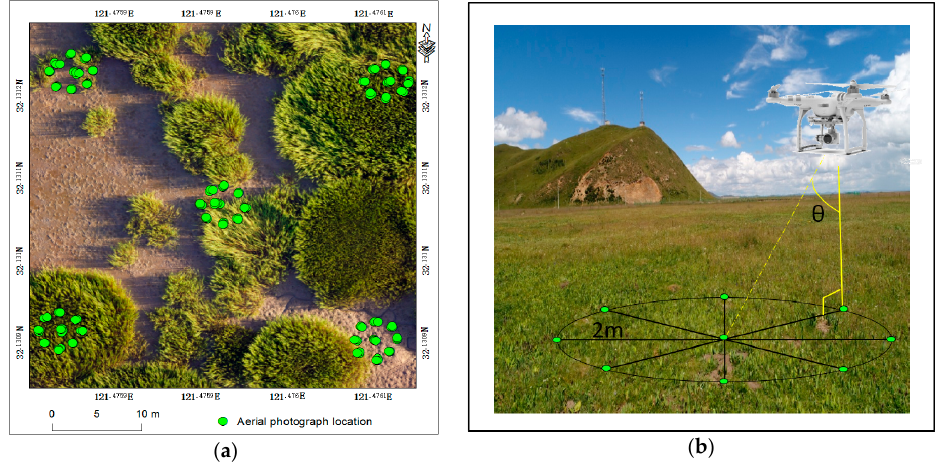
Figure 3. The unmanned aerial vehicle (UAV) flight trajectory of the QUADRAT flight mode ( a ); and the UAV shooting mode diagram for each quadrat ( b ); (the solid green dots are locations of aerial photographs). Remote Sens. 2018 , 10 , x FOR PEER REVIEW